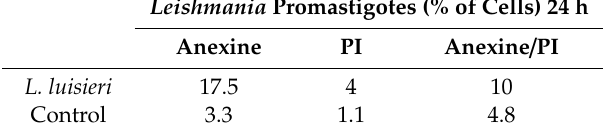
Table 3. Flow cytometry analysis of Leishmania infantum promastigotes treated with Lavandula luisieri essential oil, showing the percentage of propidium iodide (PI) and annexin-V positive cells.